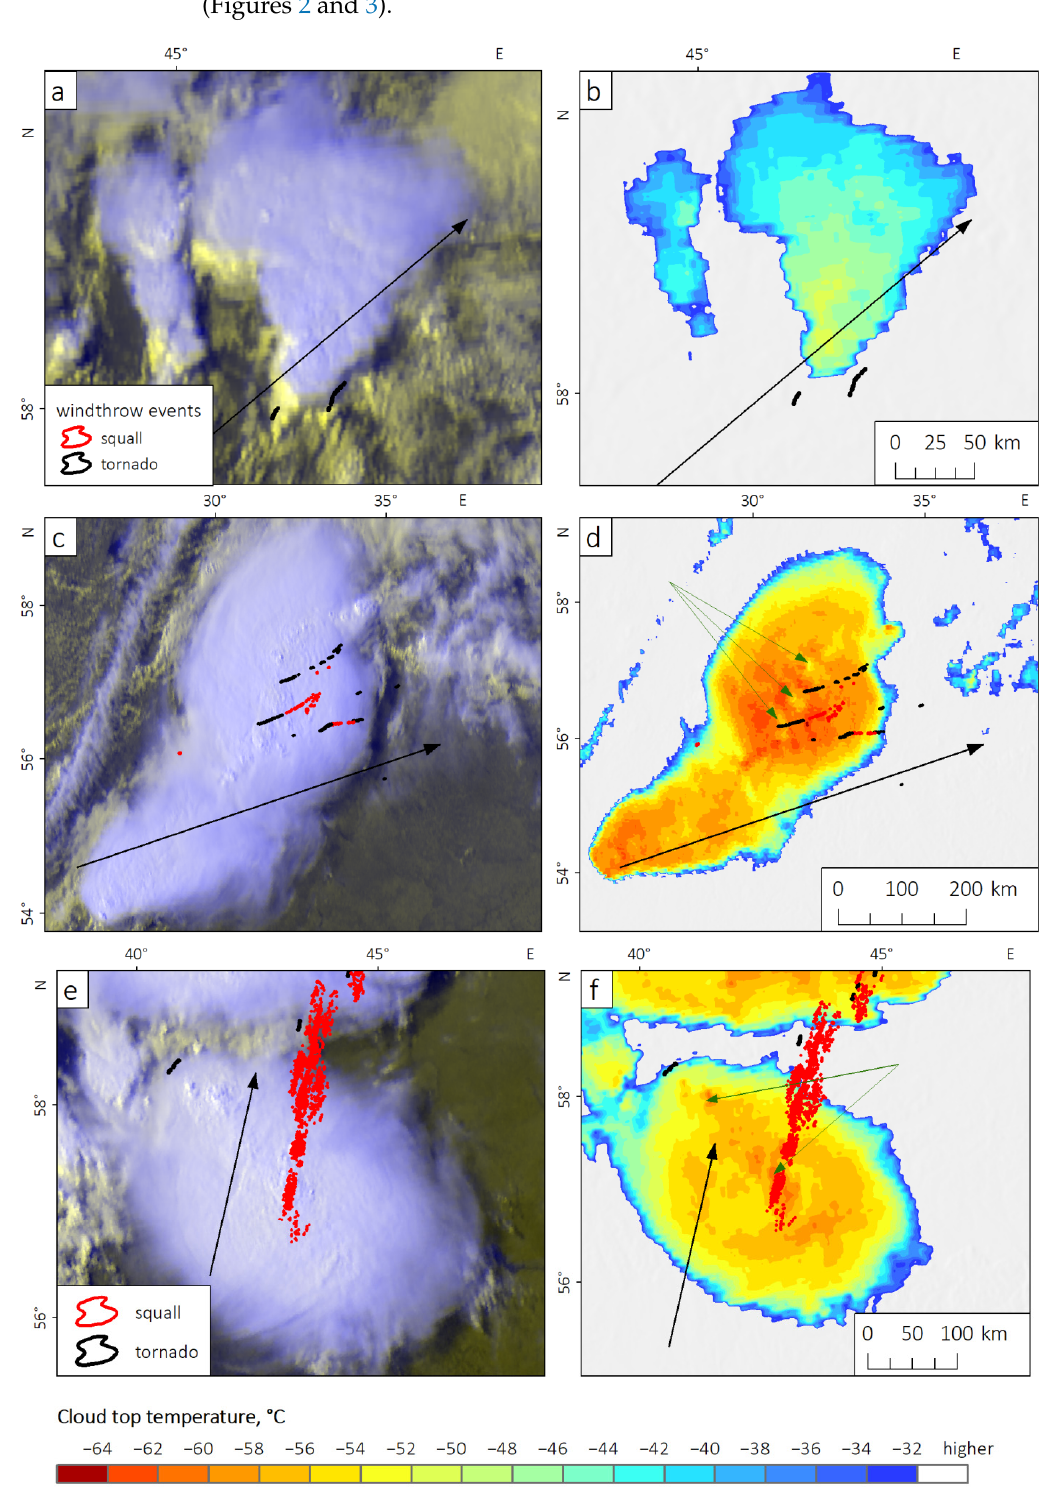
Figure 3. Examples of the MSG2 images (HRVcloud RGB composite— left column, IRW10.8 channel— right column) of the convective storms that induced windthrow events: ( a , b )—supercell on 19 August 2019, 12.00 UTC; ( c , d )—squall line on August 2, 2017, 14.30 UTC; ( e , f )—MCC on 15 May 2021 (14.00 UTC). Black arrows show the direction of storm movement, green arrows indicate ( d )—cold-ring signatures, and ( f )—OT signatures.